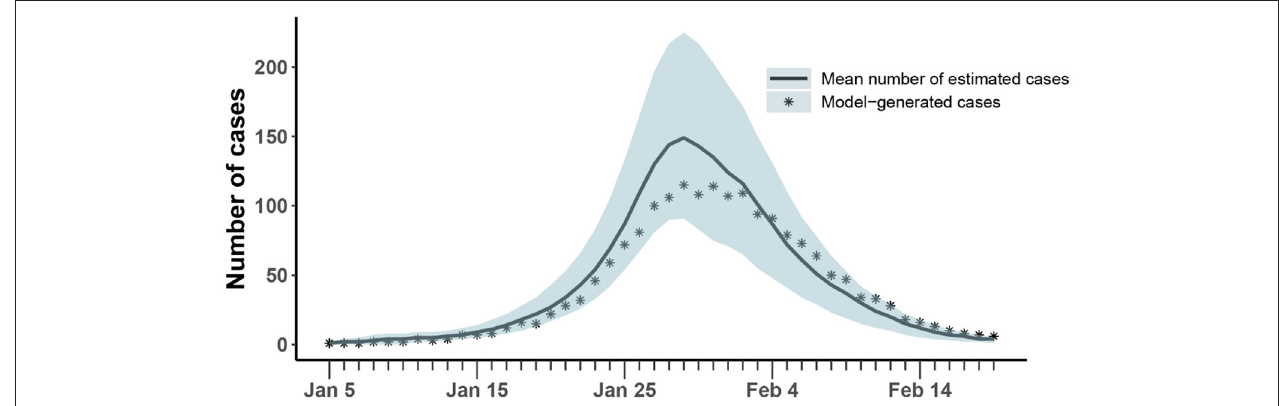
FIGURE 4 | Comparison of the number of cases estimated and generated. The asterisk represents the number of cases with symptoms observed on a daily basis; the curve shows the change in the average number of confirmed symptomatic cases per day estimated by the model. The light blue shade was the 95% confidence interval of the estimation.